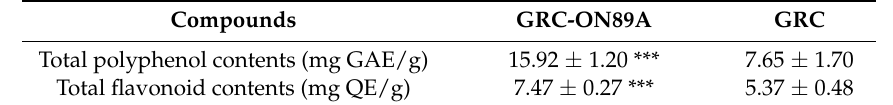
Table 2. Total polyphenol and flavonoid content in Cordyceps militaris grown on germinated Rhynchosia nulubilis (GRC) and GRC fermented with Pediococcus pentosaceus ON89A isolated from onion (GRC-ON89A).